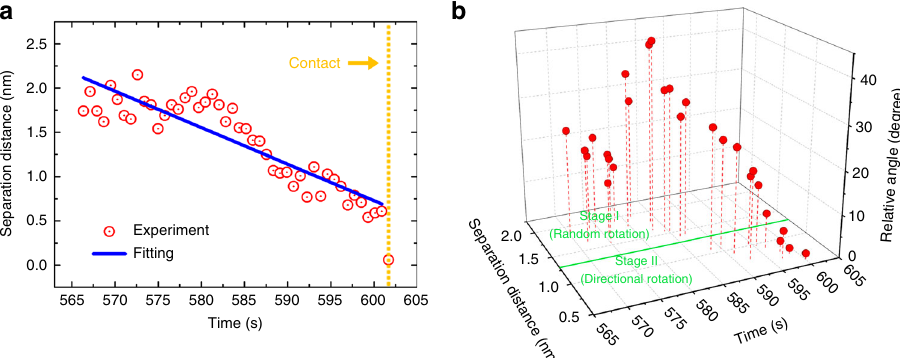
Fig. 2 Dynamics of pairwise particles during OA. a Change in surface separation distance of a particle pair with time. The orange dashed line at 601.7 s denotes the occurrence of jump to contact. b The relative angle between the {111} facets of the particle pair vs. the separation distance and time. The green line at D = 1.30 nm is the separation point between stage I and stage II as the particle pair approaches each